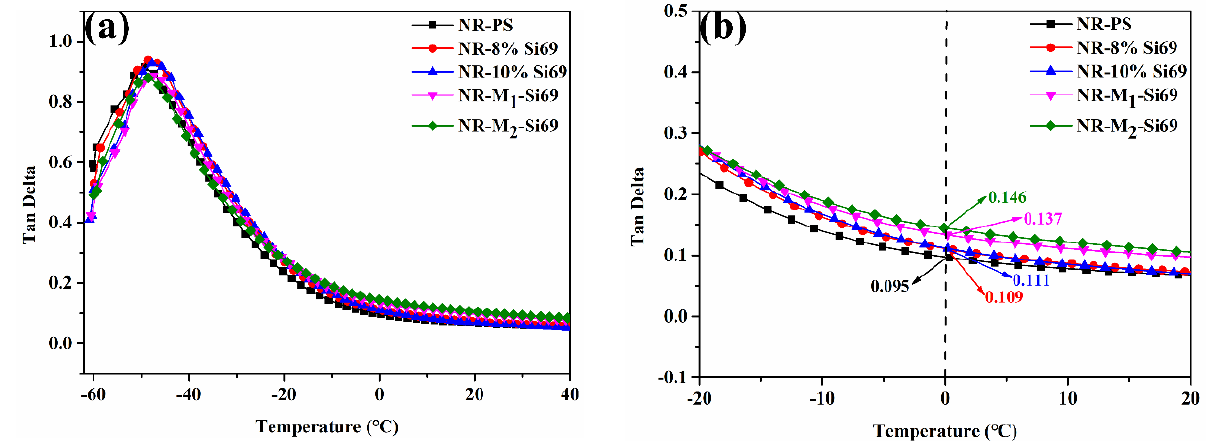
Figure 13. DMTA curves of silica/rubber nanocomposites.